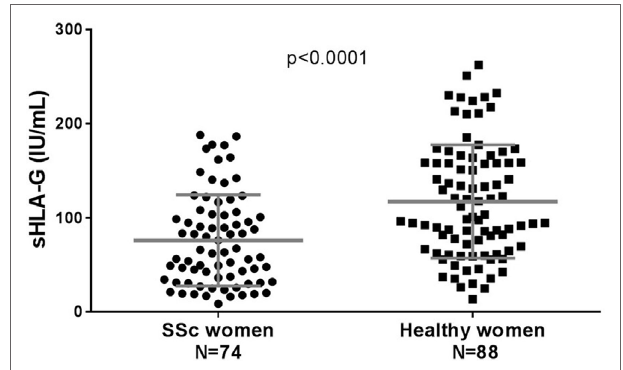
FigUre 1 | Quantification of soluble HLA-G (sHLA-G) in plasma from healthy and SSc women. Quantification of sHLA-G is expressed in International Units per mL of plasma (IU/mL). Black circles represent values for women with SSc and black squares represent values for healthy women. Means and SDs are given for each scatter plot by gray bars. P value is calculated by Mann– Whitney test.